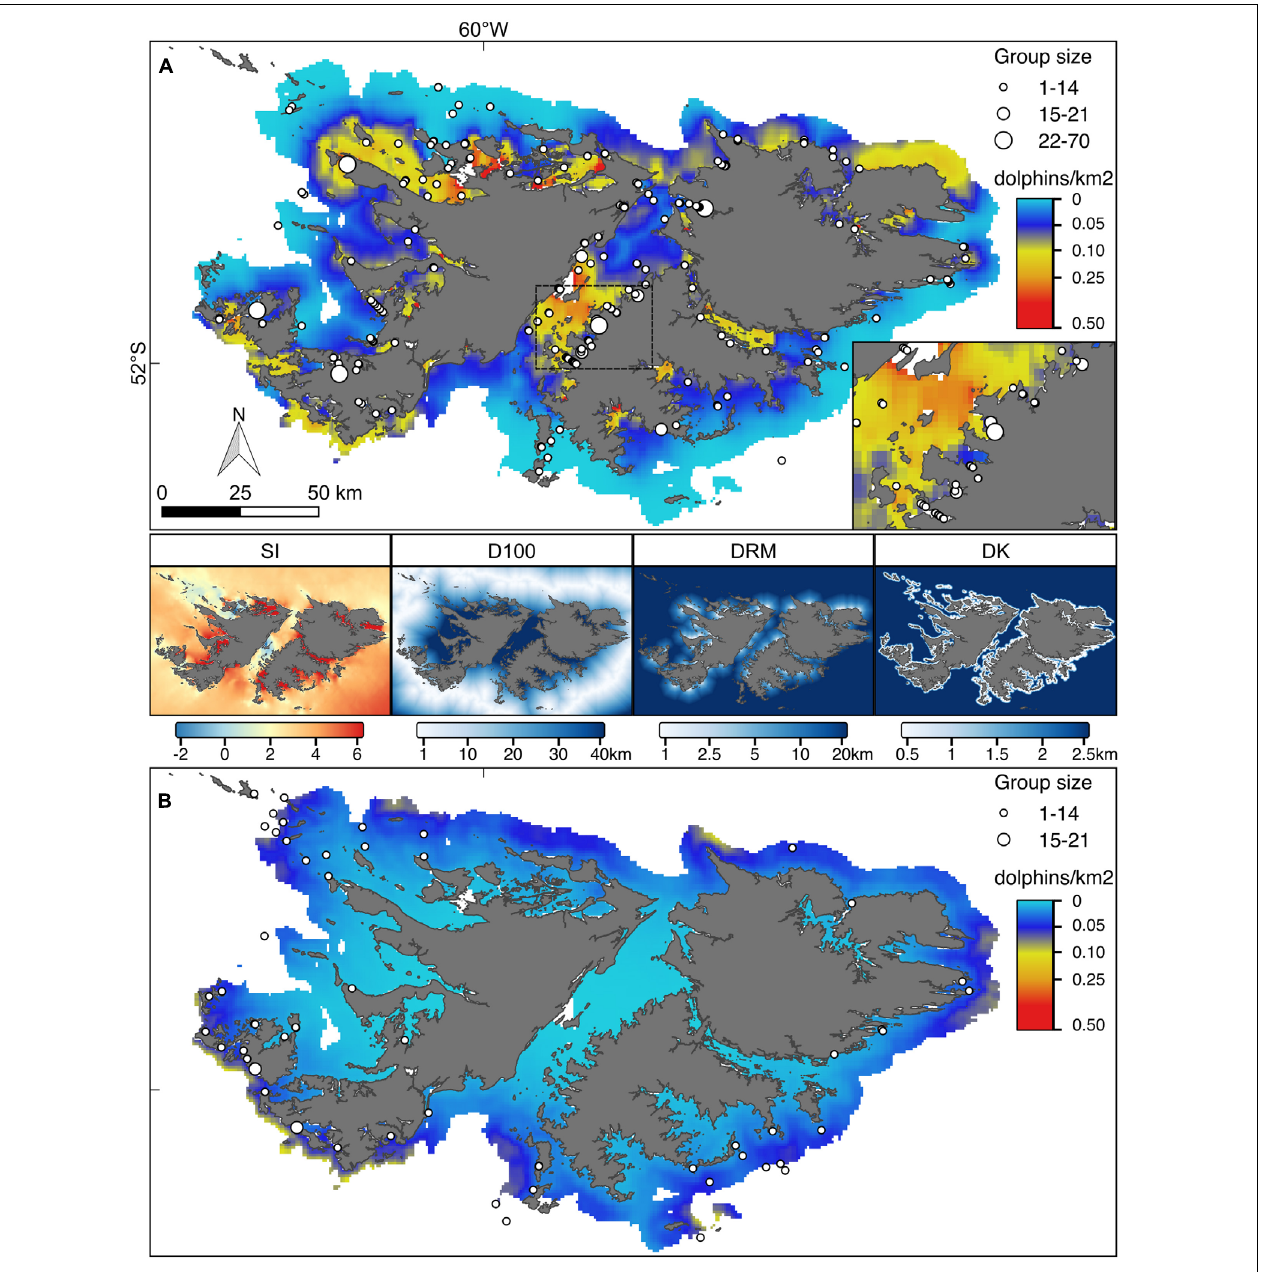
FIGURE 4 | Hurdle model point estimates for the predicted number of Commerson’s and Peale’s dolphins ( A and B , respectively). Superimposed locations represent the sightings collected during the aerial surveys conducted in 2017. Symbol size is proportional to the observed group sizes. Inset in (A) magnification of the central part of the Falkland Sound for Commerson’s dolphins. Both maps are reported on the same colour scale. The four maps in the middle show the covariate values: SI, water stratification index; D100, distance to 100 m isobaths; DRM, distance to main river mouth; DK, distance to